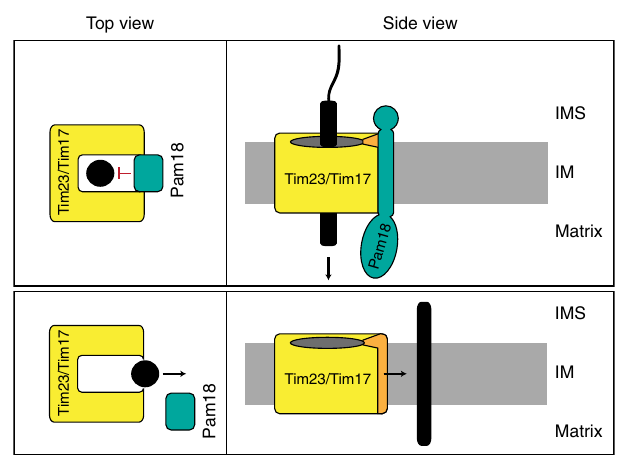
Fig. 5 Pam18 controls the lateral gate promoting anterograde protein transport. Model of how Pam18 might affect release of membrane-targeted proteins into the lipid bilayer. When Pam18 is bound together with other motor components, the lateral gate is closed, which promotes matrix translocation of substrates. IMS, intermembrane space; IM, inner